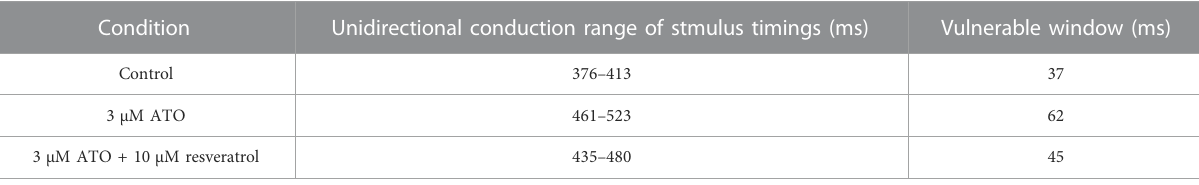
TABLE 3 Effect of resveratrol on the ATO-induced ventricular cable